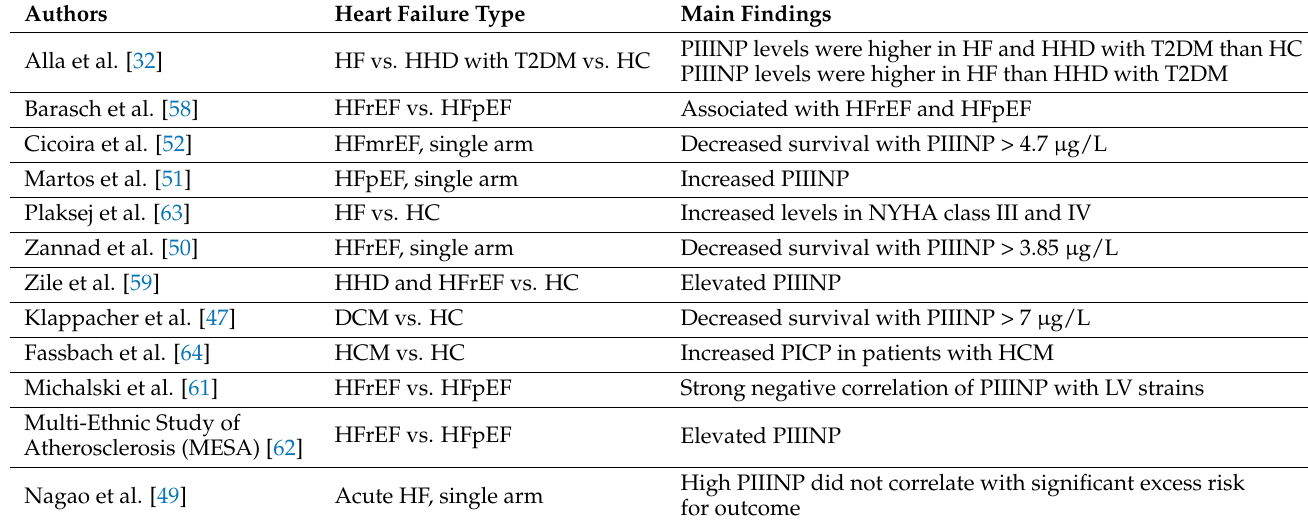
Table 1. Serum PIIINP concentrations in patients with heart